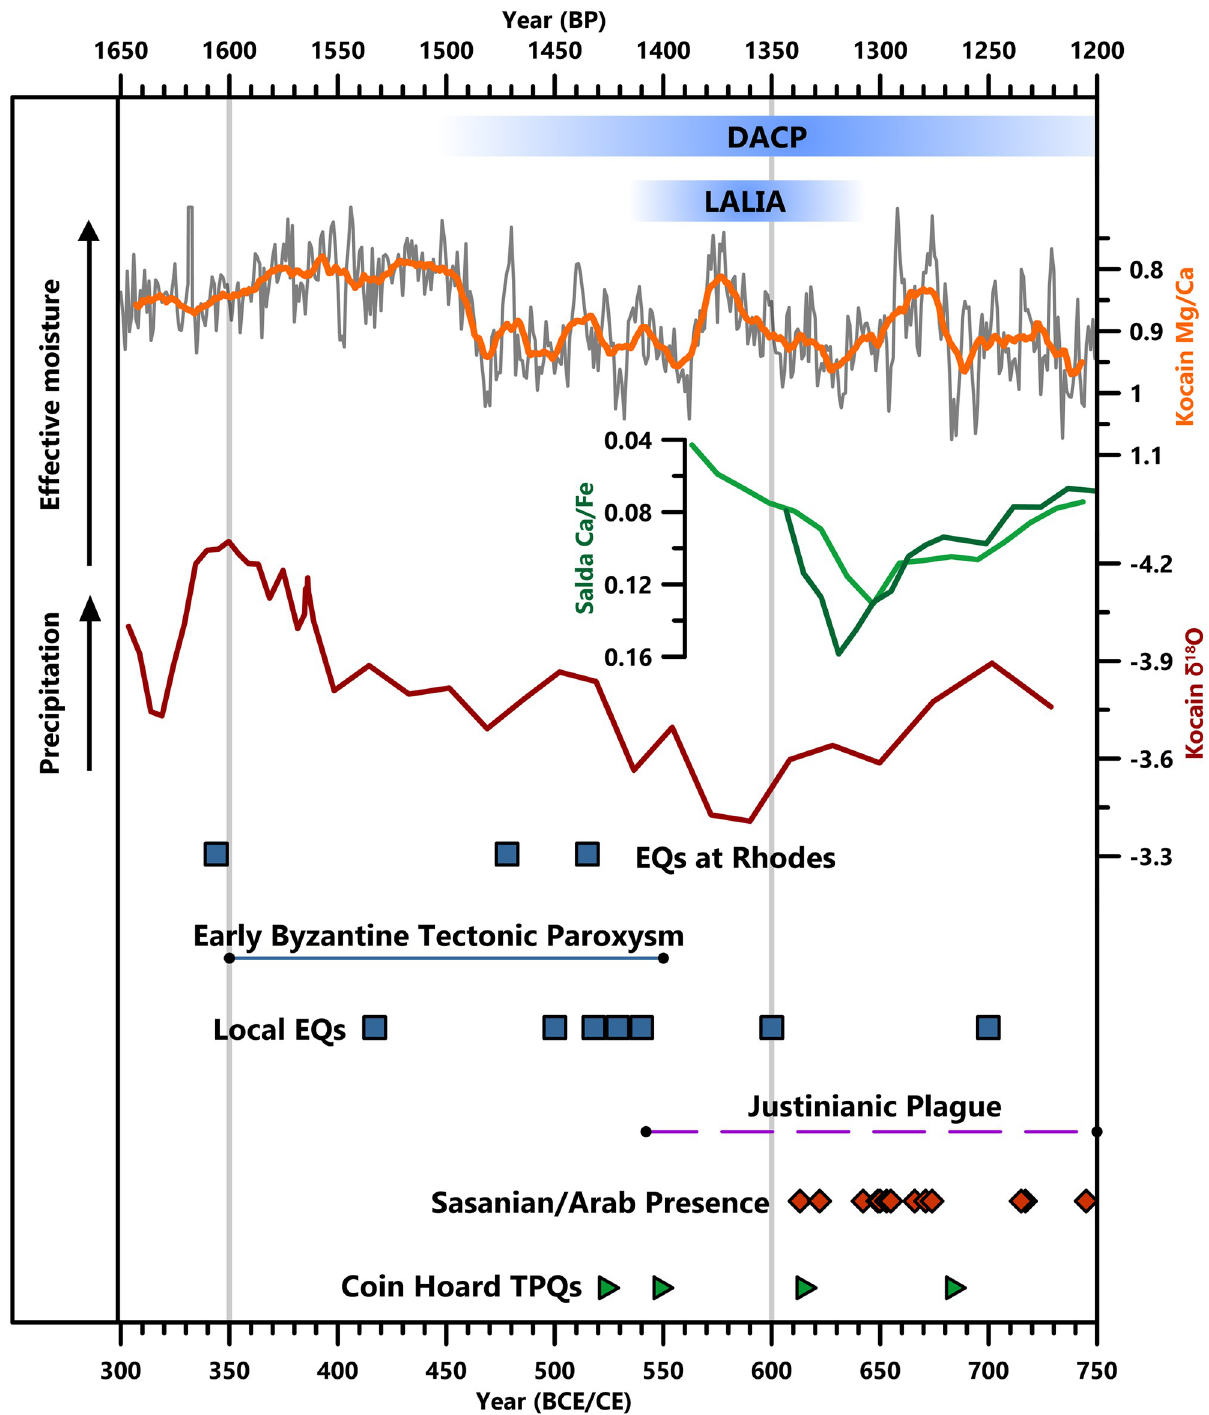
Fig 8. Climate changes and other events during the Early Byzantine and Middle Byzantine periods. The Ko-1 Mg/Ca record is displayed as annual (grey line) and 15-year (orange line) averages. Coin hoards, indicative of insecurity, are displayed by their terminus post quems (TPQs), indicating their earliest possible date of deposition (S3